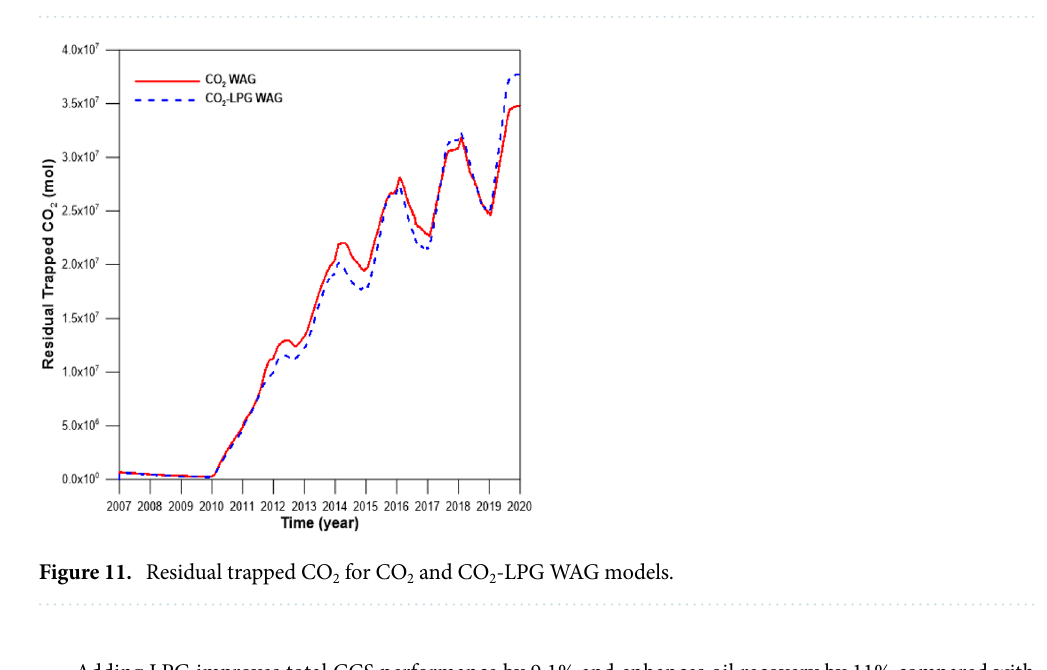
Figure 10. ( a ) Gas relative permeability and ( b ) residual water saturation during CO 2 and CO 2 -LPG WAG injection.